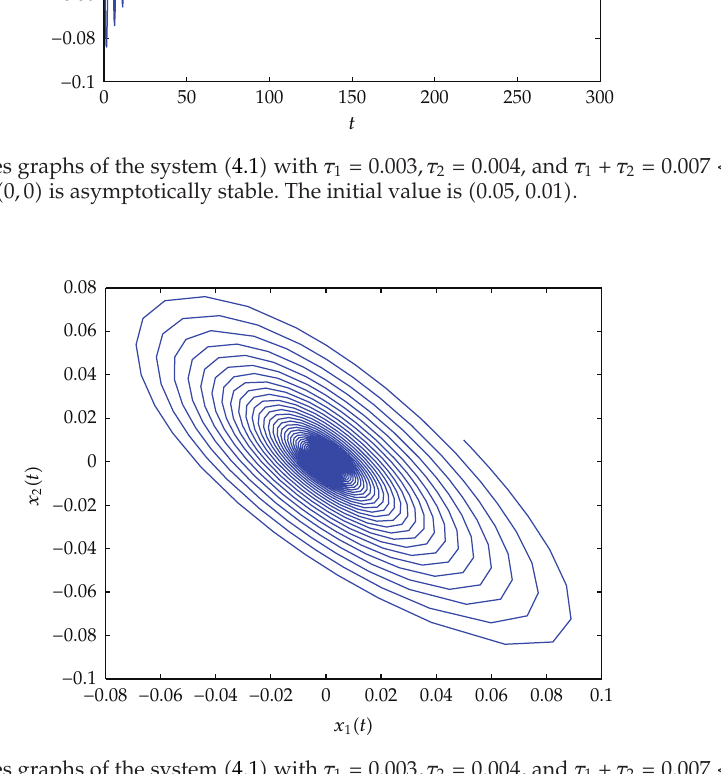
By some complicated computation by means of Matlab 7.0, we get ω 0 ≈ 1 . 3211, τ 0 ≈ 0 . 01, λ (cid:4) (cid:2) τ 0 (cid:3) ≈ 0 . 0140 − 1 . 4926 i . We can easily obtain g 20 (cid:6) − 0 . 2501 (cid:7) 2 . 3128 i , g